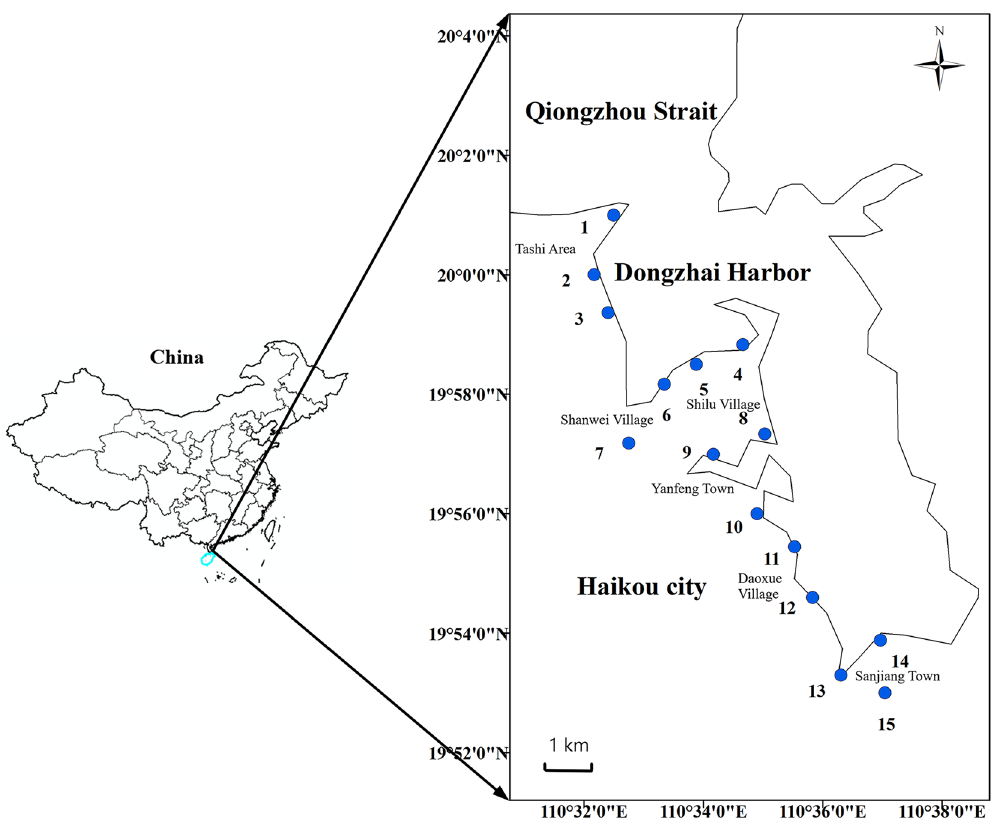
Fig. 1 Maps of the study area. Map of China, including the entire Hainan province and Dongzhai harbor. Blue circle symbols (1–15) repre- sent sampling stations that were investigated during February and August yearly from 2013 to